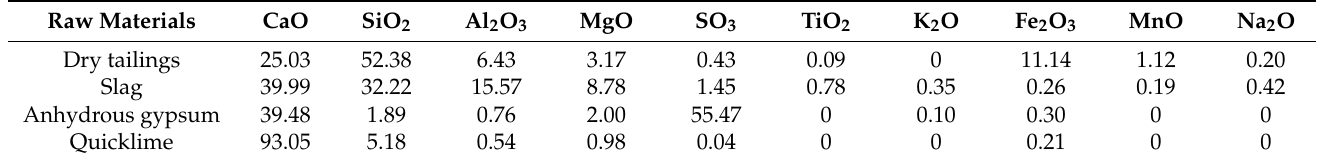
Table 1. Chemical composition of dry tailings and other raw materials by XRF (weight ratio